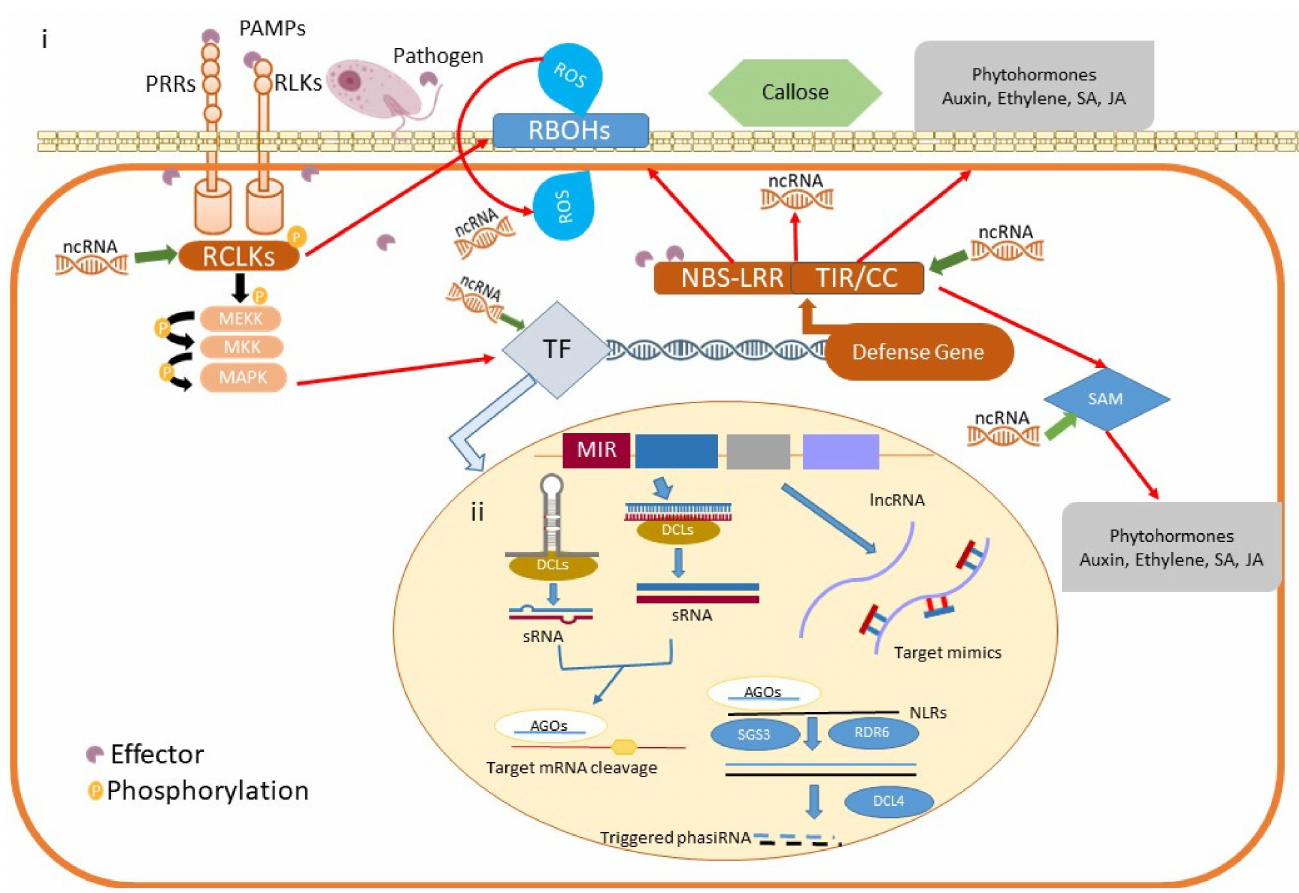
Figure 1. ( i ) shows ncRNAs (miRNA, lncRNA, sRNA) regulate immune receptor such as RCLKs, and results in MAPK kinase activation and the induction of transcription factors leading to activation of defense response. ncRNAs are involved in the phytohormone, ROS and resistance gene activation through the NBS–LRR/TIR/CC domains. Thus, this leads to various plant immunity mechanism being activated and modulated resulting in production of hormones, defense proteins and structural changes, such as calloses. ( ii ) ncRNAs (miRNA, lncRNA, sRNA) synchronized activity in plant immunity. The synthesis of phasiRNAs can be triggered by miRNAs that target NLR genes. Target mimics and miRNA/sRNA precursors are the major functions of lncRNAs. miRNA/sRNA that are incorporated to AGO and leads to mRNA